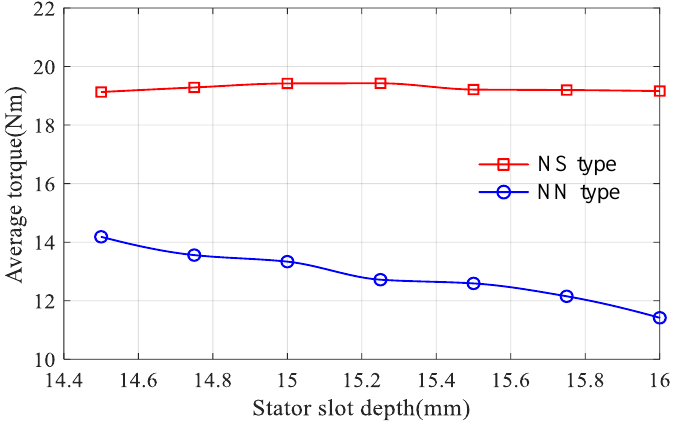
Figure 6. Influence of stator slot depth on average torque.